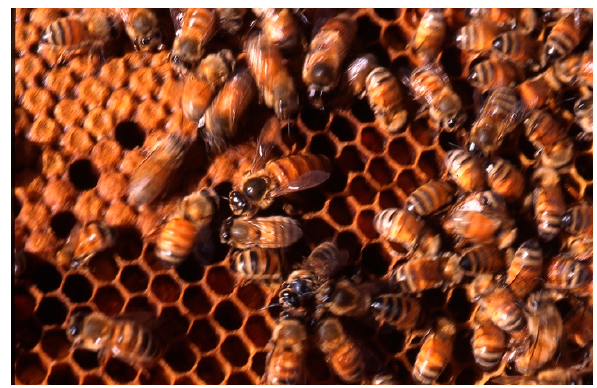
Figure 1. Apis mellifera (copyright Dany El Obeid) .